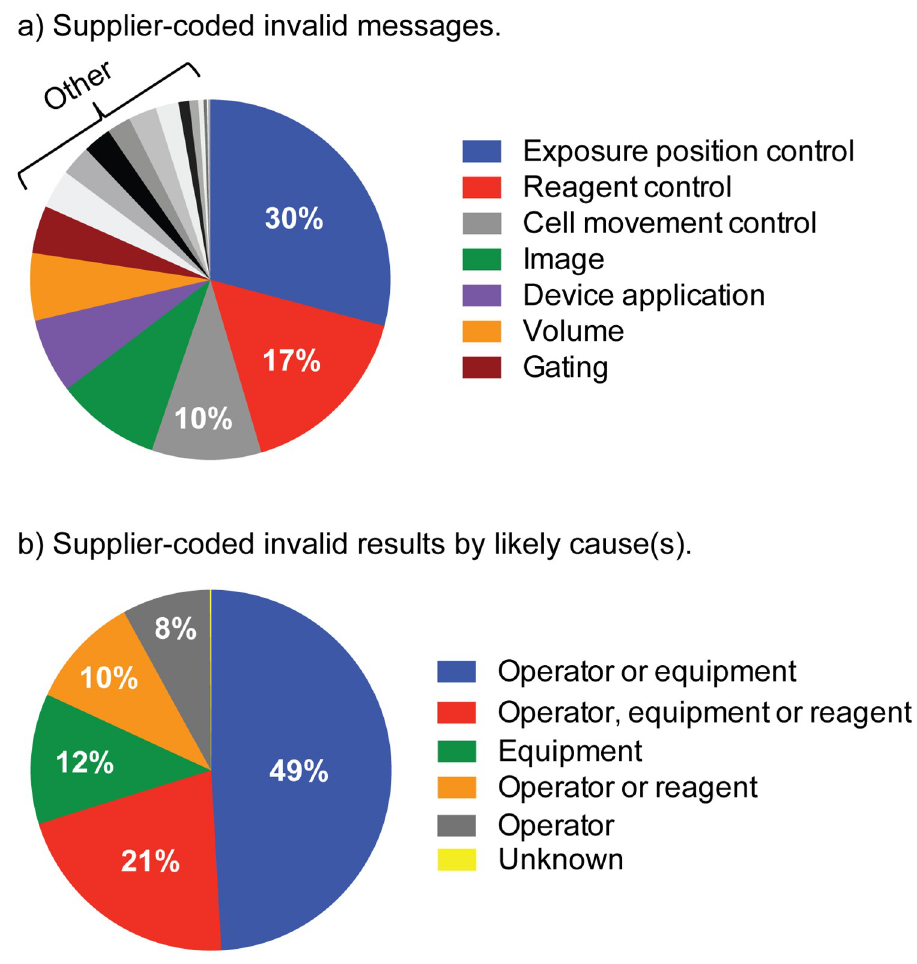
Fig 1. Supplier-coded invalid messages (a) and invalid results by likely cause(s)